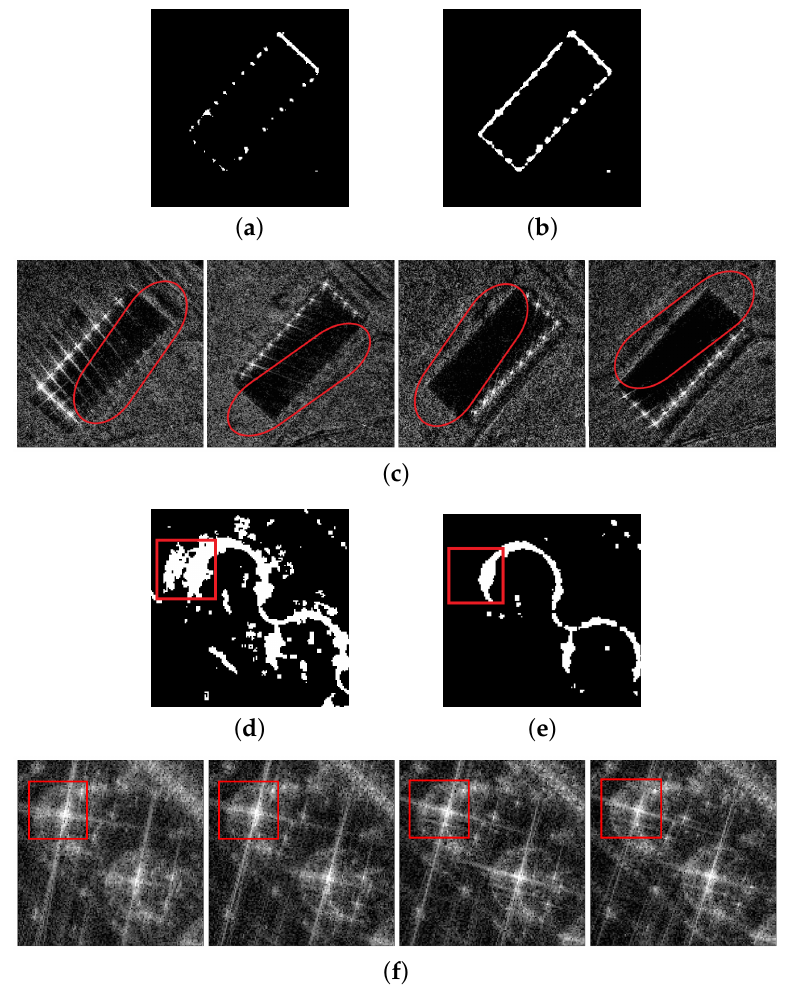
Figure 16. The comparison of the binary images by Rayleigh and G 0 approaches. ( a ) The building area of the Rayleigh approach. ( b ) The building area of G 0 approach. ( c ) The multi-angular images of the building area. ( d ) The storage tanks of the Rayleigh approach. ( e ) The storage tanks of G 0 approach. ( f ) The multi-angular images of the storage